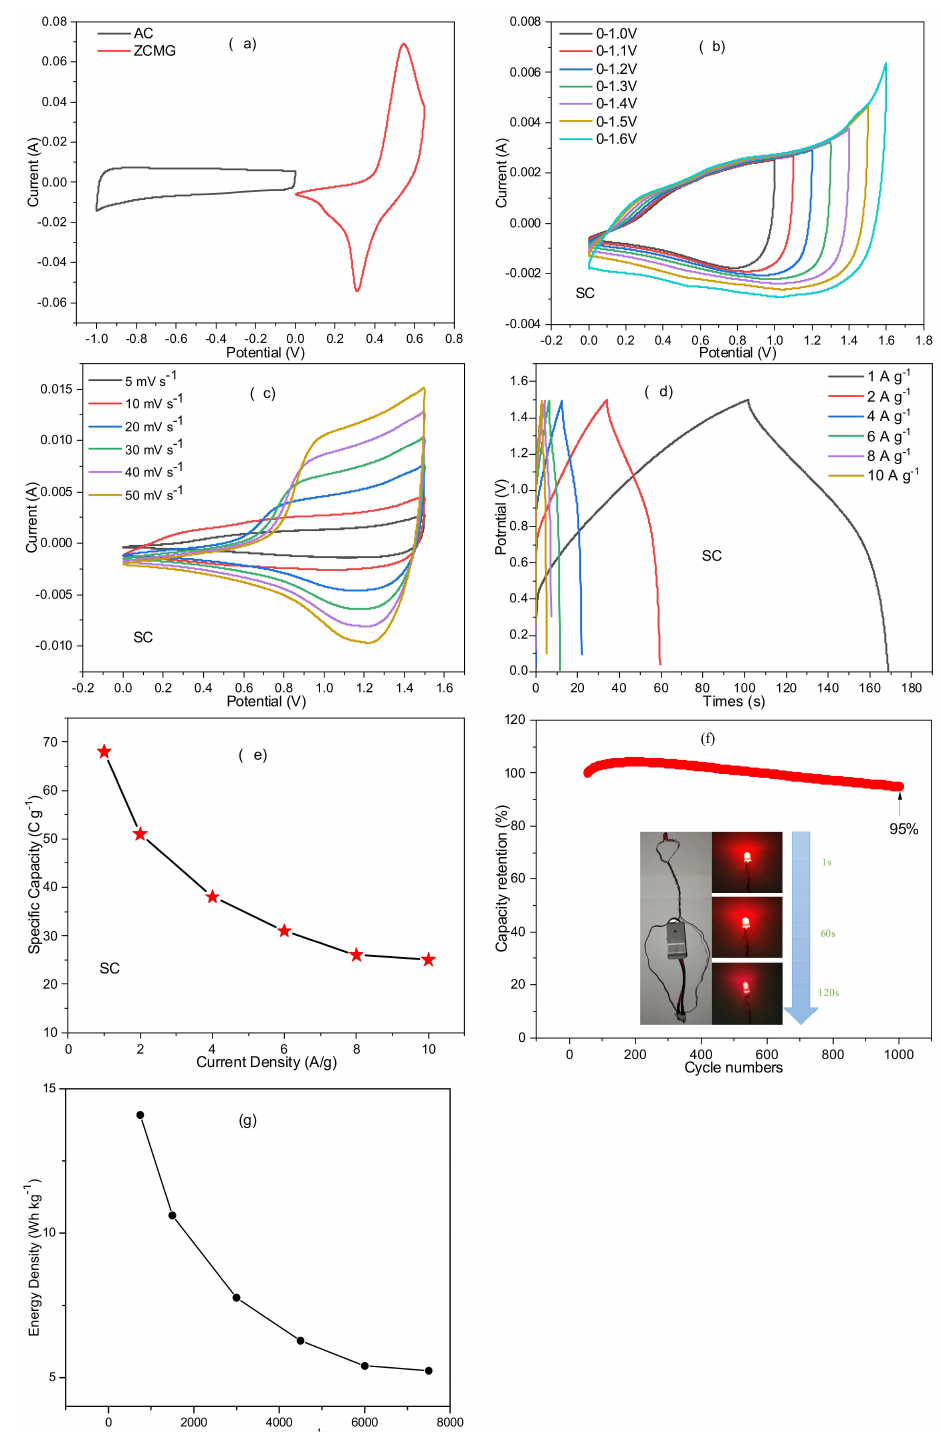
Figure 8. ( a ) CV plots of ZCMG and AC electrodes at 20 mV s − 1 . ( b ) CV plots of ASCs at different voltage ranges. ( c ) CV plots of ASCs at different scan rates. ( d ) GCD plots of ASCs at different current densities. ( e ) Specific capacity plots of ASCs at different current densities. ( f ) Cycling performance of ASCs at 1 A g − 1 , the inset shows the physical demonstration of driving LED lamp with two hybrid SCs. ( g ) Ragone diagram of